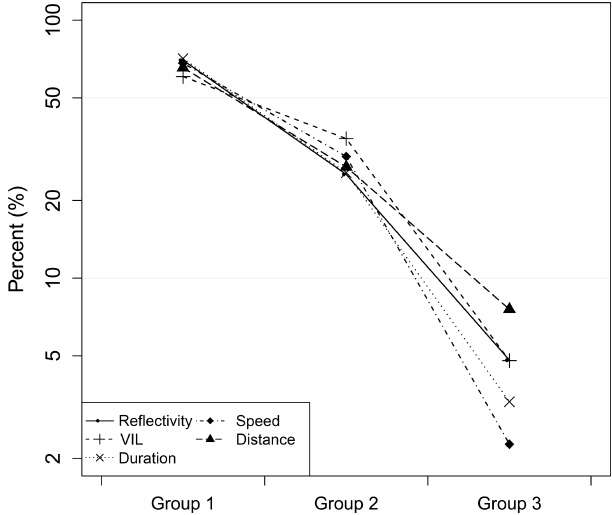
Figure 8. Distribution of parameters of convective storms as a func- tion of their